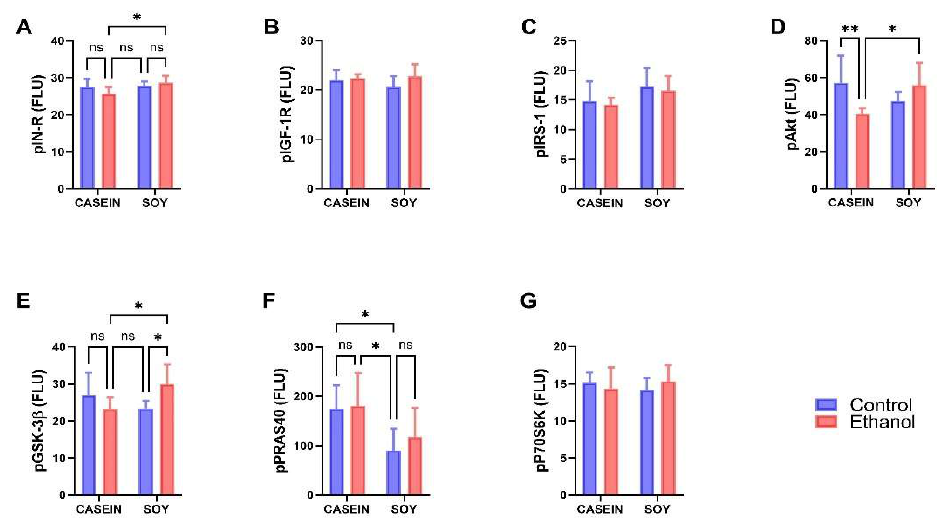
Figure 4. Effects of chronic ethanol and dietary soy isolate on insulin-IRS-1-Akt pathway phospho-protein expression in temporal lobe. Long Evans male and female young adolescent rats were fed for 7 weeks with isocaloric liquid diets containing 0% or 37% (3 weeks) followed by 26% (4 weeks) ethanol and casein (standard) or soy isolate as the protein source. Temporal lobe homogenates were used to measure ( A ) pYpY1162/1163 -IN-R, ( B ) pYpY1135/1136 -IGF-1R, ( C ) pS312 -IRS-1, ( D ) pS473 -Akt, ( E ) pS9 -GSK-3 , ( F ) pT246 -PRAS40, and ( G ) pTpS421/424 -p70S6K with the Phospho Akt Magnetic 7-Plex Panel. Data from the male and female rats were combined since there were no sex-related differences. Graphed data reflect the mean ± S.D. of immunoreactivity expressed as fluorescence light units (FLU). Results were analyzed with two-way ANOVA tests (Table 4) with post hoc Tukey tests. Significant p- Values are indicated above the bars. * p < 0.05; ** p < 0.01; ns = not significant.